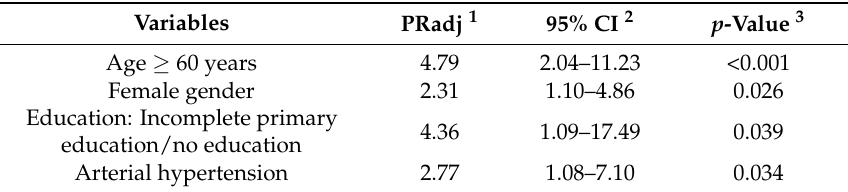
Table 2. Multiple regression analysis of risk factors for diabetes mellitus (DM) in the adult population of Maranh ã o, National Health Survey,